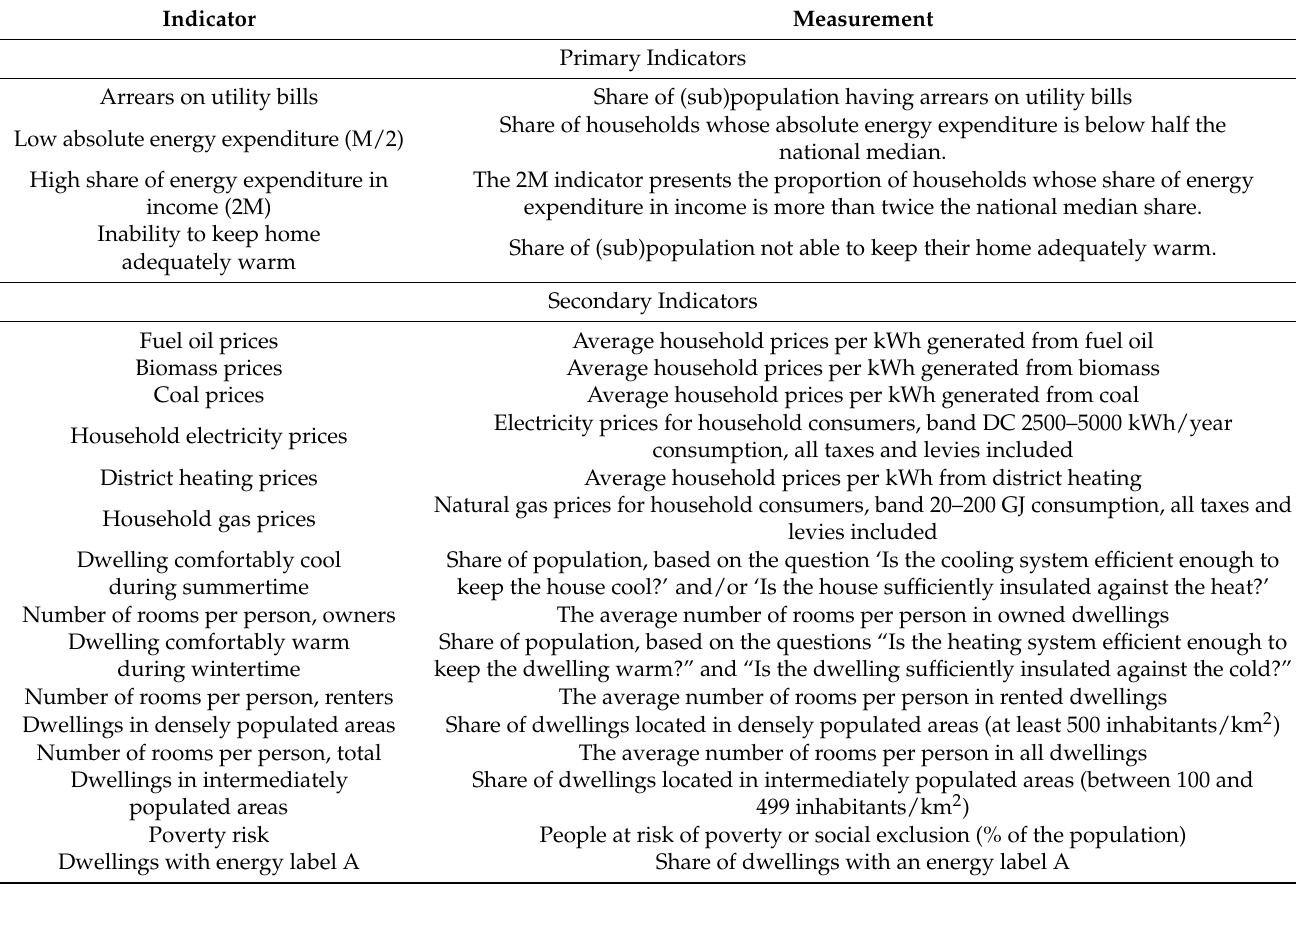
Table 2. Energy poverty (EPOV)